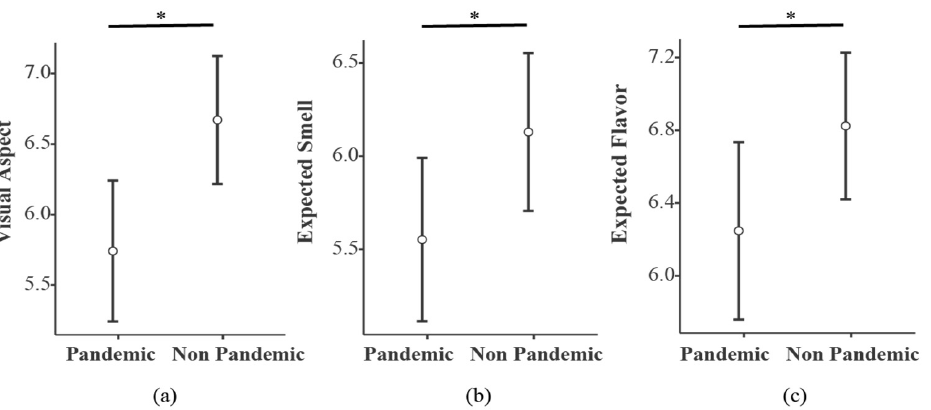
Figure 5. Comparison between video condition evaluations of expected flavor, smell and visual aspect. ( a ) Flavor expectation compared between Pandemic (M = 6.25, SD = 2.29) and Non-Pandemic (M = 6.82, SD = 1.90) conditions showed higher scores for the Non-Pandemic condition; ( b ) Visual aspect between conditions showed higher rates for the Non-Pandemic condition (M = 6.67, SD = 2.13) compared to the Pandemic condition (M = 5.77, SD = 2.35); and ( c ) Smell expectation, comparing the Pandemic condition (M = 5.55, SD = 2.06) to the Non-Pandemic condition (M = 6.13, SD = 1.99), showed higher scores for the Non-Pandemic condition. The letter ‘C’ on the plots stands for Pandemic condition, while the letters ‘NC’ stand for Non-Pandemic condition. Confidence interval bars are also depicted (95%). (*) p = <0.05.